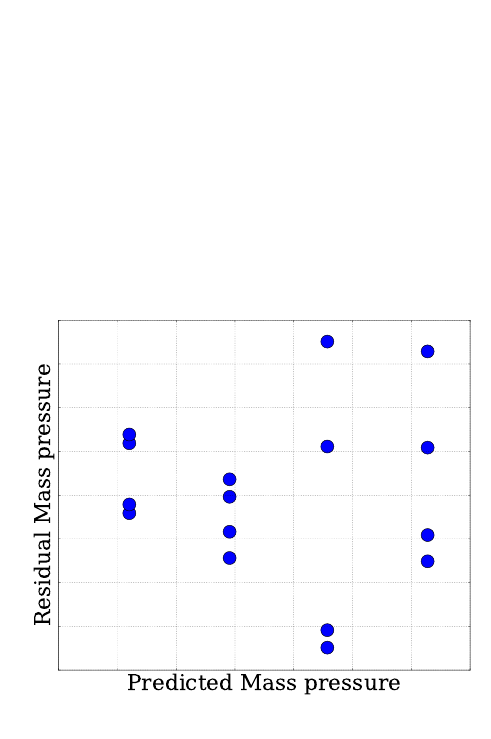
Figure 17: Residuals as a function of predicted values after modeling for mass